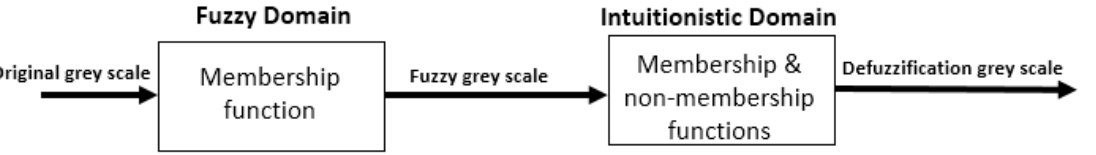
Figure 1. Representation of the intuitionistic fuzzy process of images.